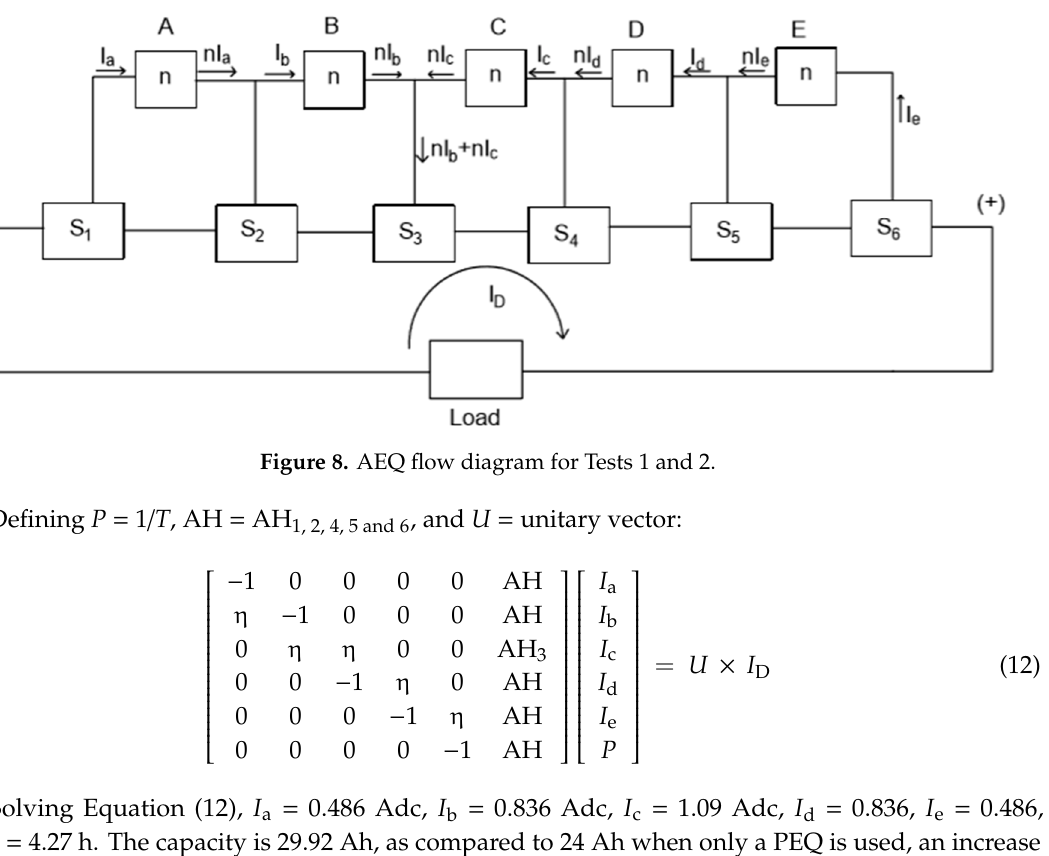
Table 1. Calculated and measured results for Tests #1 and #2.